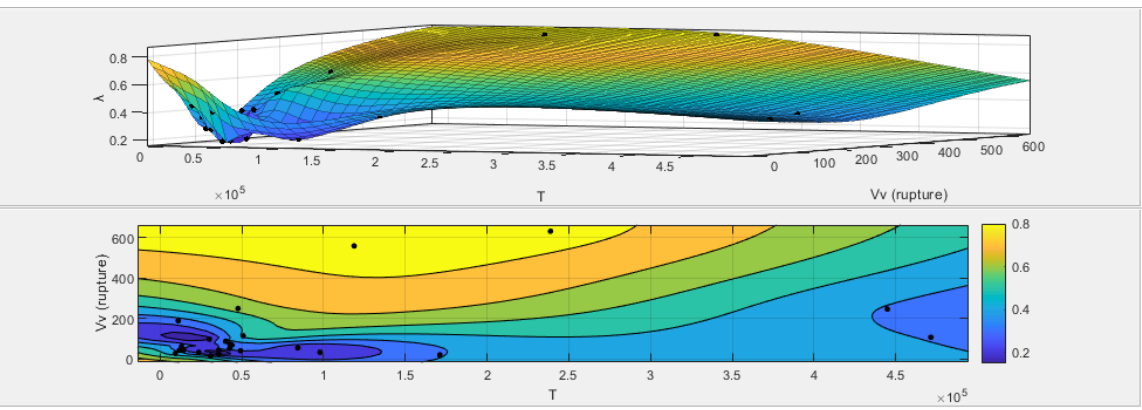
Figure 12. Gaussian Vv vs. T curve fitting with residuals. Table 2. Gaussian curve fitting model parameters for Vv vs. T .